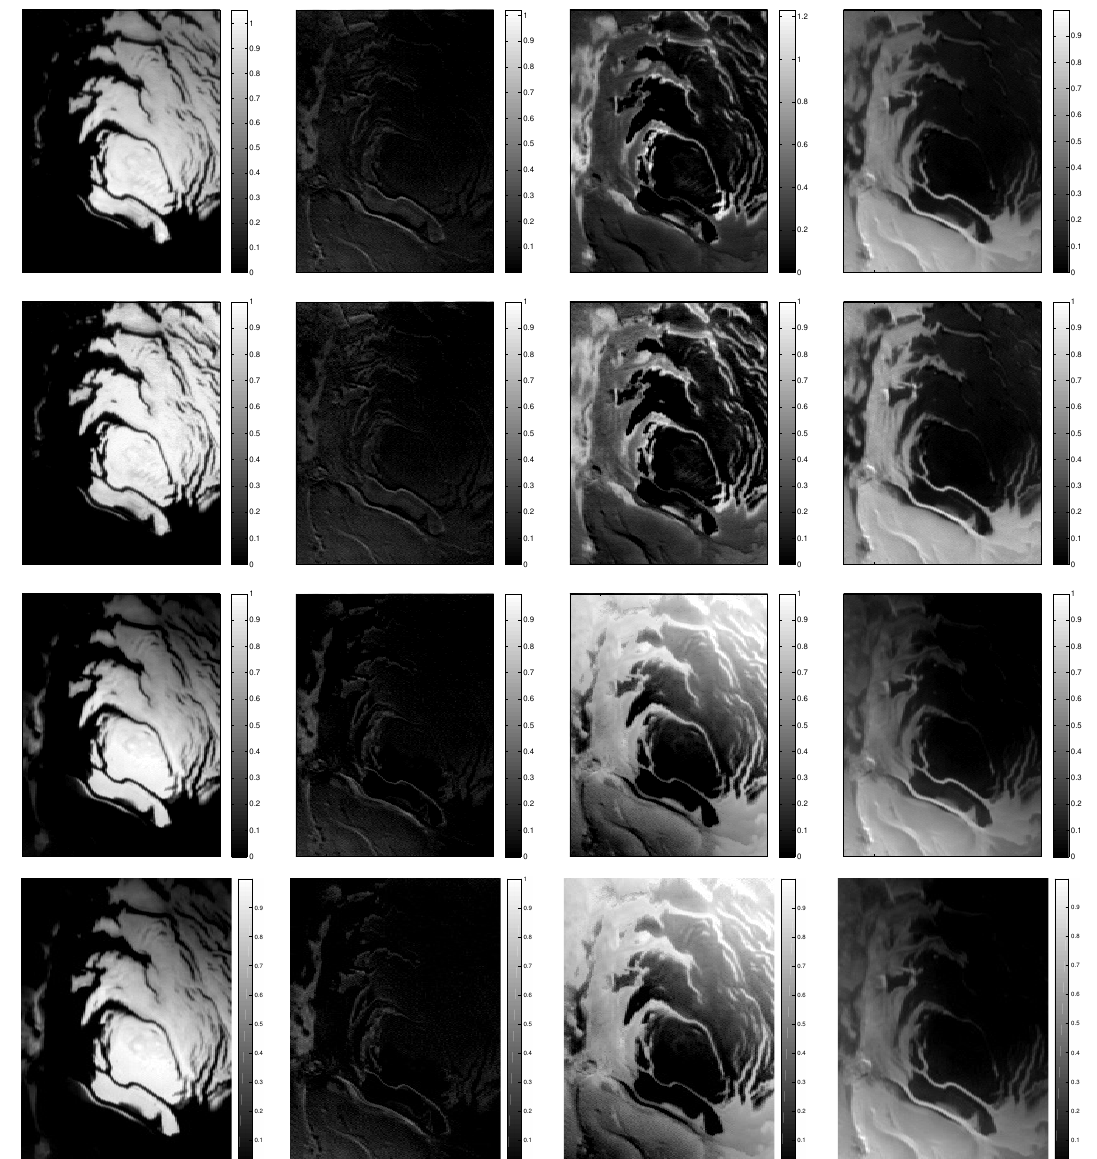
Figure 9. Abundance maps computed with the spectra of the endmembers extracted by VCA. The abundances are, respectively, estimated by the use of NNLS (first row), normalized NNLS abundances by the use of Equation (13) (second row), FCLS (third row) and MLMp (fourth row). When we compare the abundance maps estimated by using NNLS with the abundance maps of water ice, CO 2 ice and mineral dust obtained in [31] (see Figure 7), it can be seen that the abundance maps of the 1st, 3rd and 4th endmembers, respectively, correspond to CO 2 ice, water ice and dust. This observation is coherent with the identification of the spectra of the endmembers (see Section 4.3). The abundance maps of the fourth and the first endmembers estimated by FCLS correspond well to dust and CO 2 ice. However, neither the second nor the third abundance maps are similar to the abundance of water